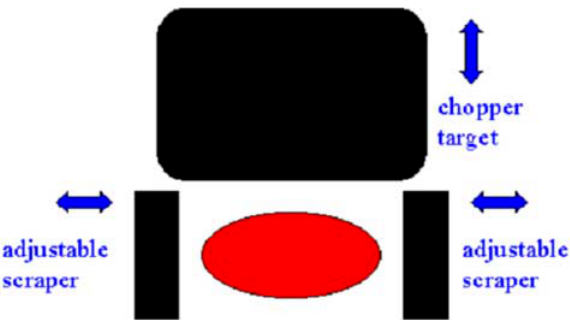
FIG. 10. (Color) Schematic drawing of adjustable MEBT colli- mators and chopper target.